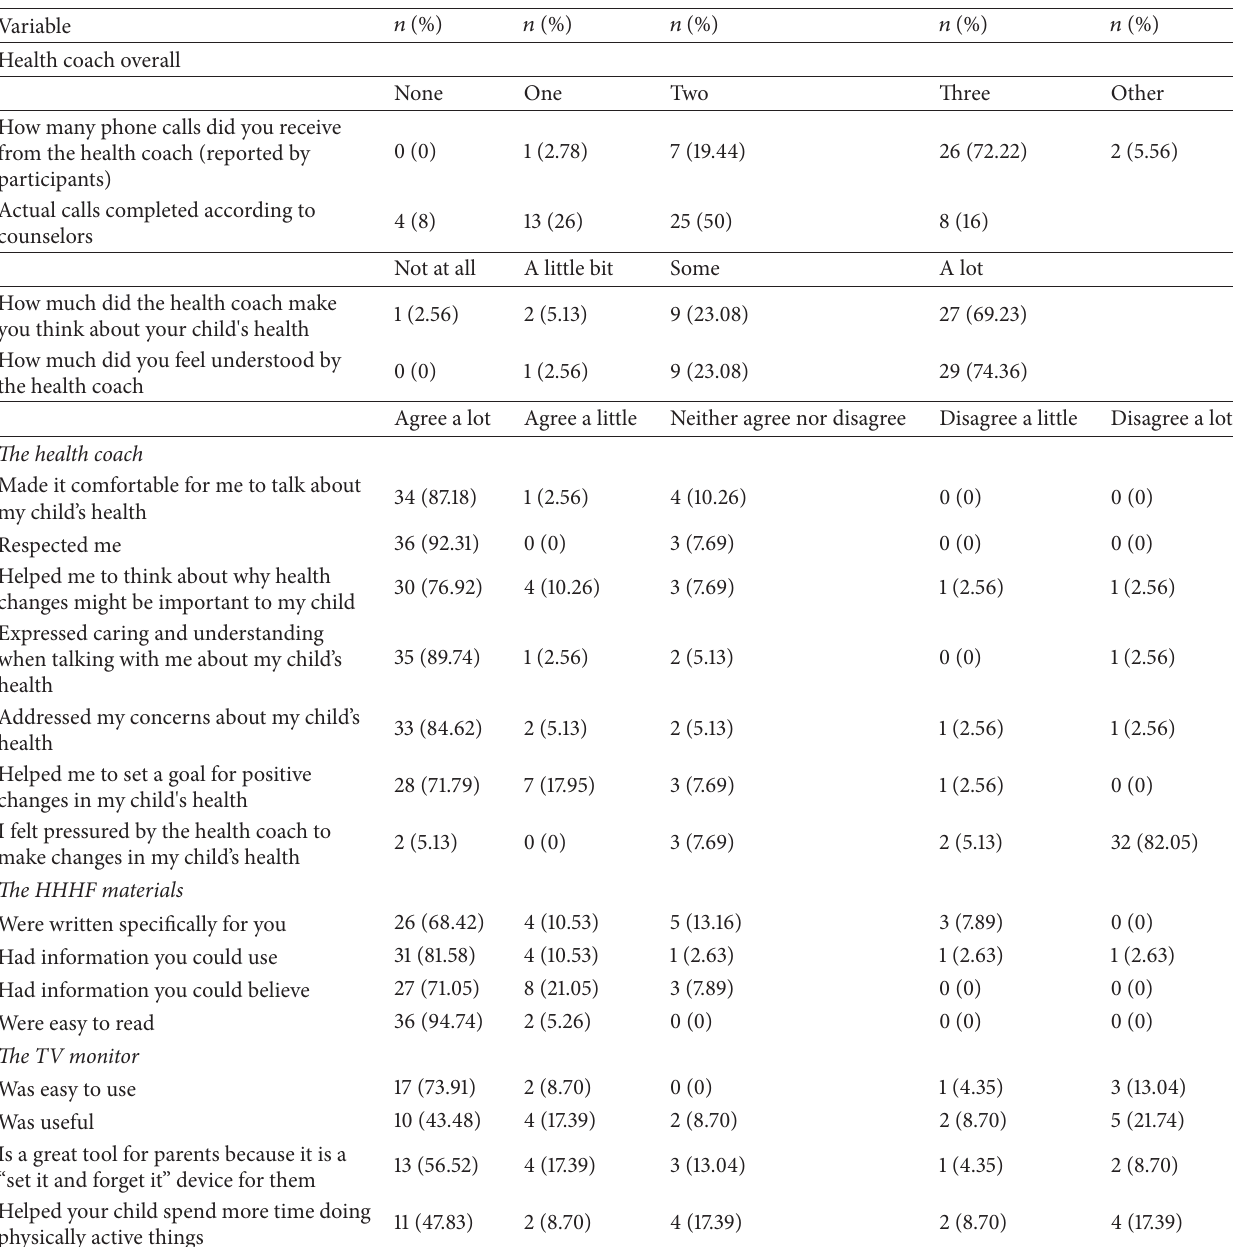
Table 2: Process evaluation